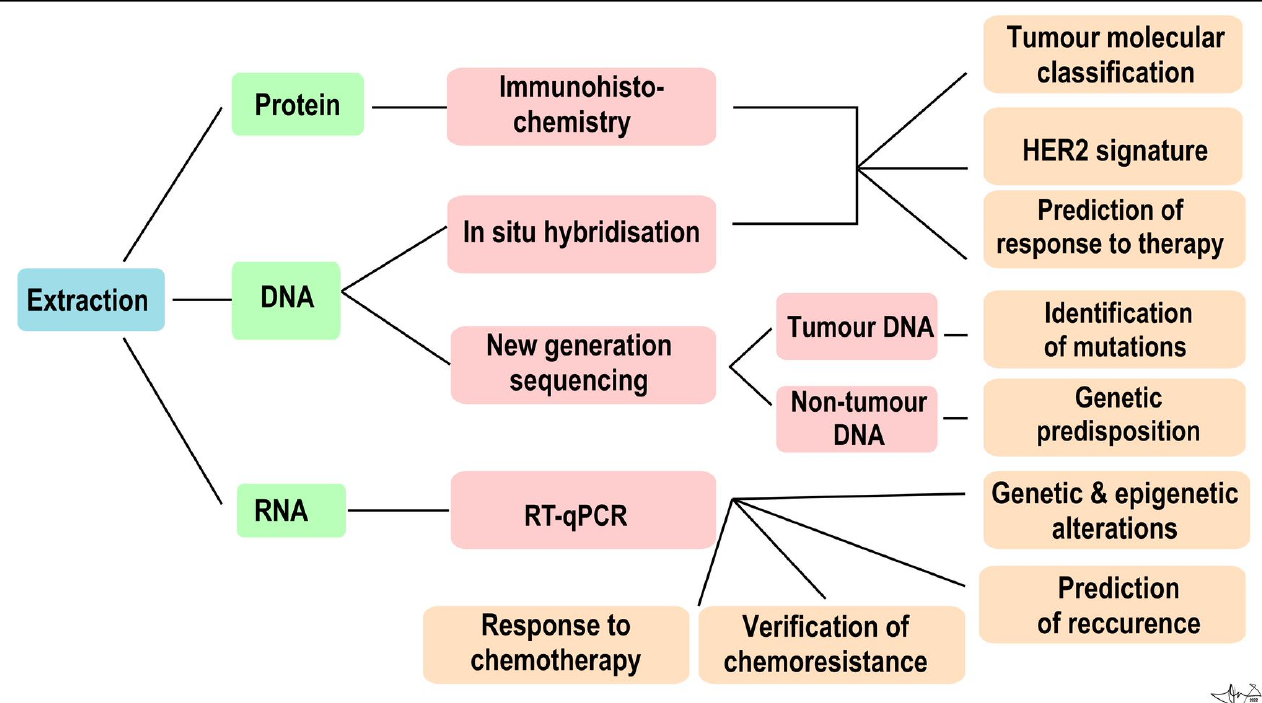
Figure 4. Algorithm of immunohistochemical and molecular genetic analysis of a tumour sample Combined [60].